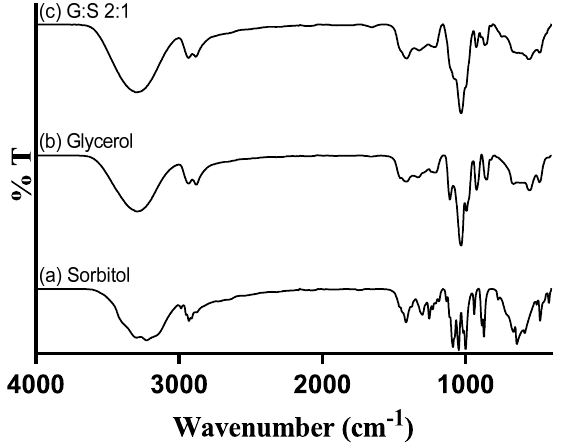
Figure 3. FTIR spectra of: ( a ) pure sorbitol; ( b ) pure glycerol; and ( c ) G:S 2:1 molar ratio.